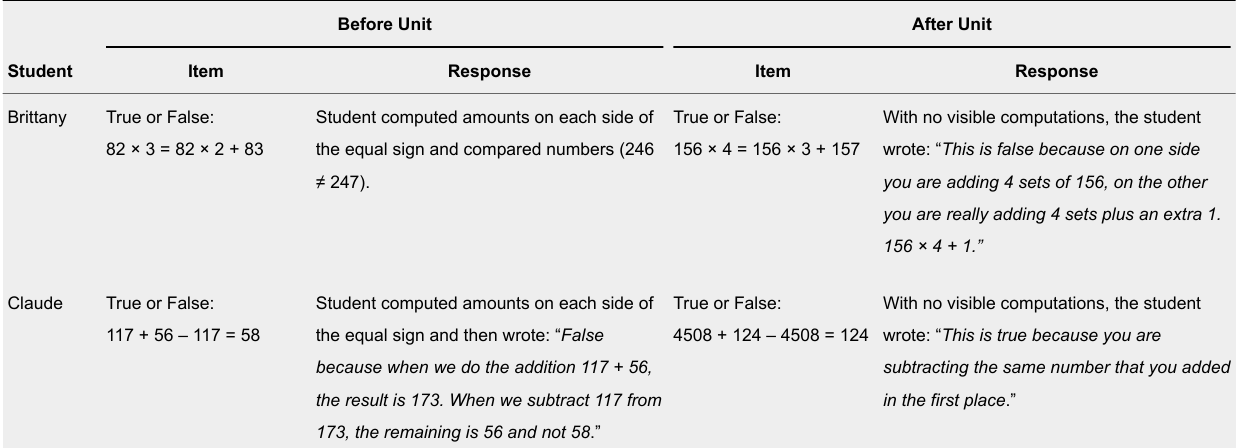
Illustrative Examples of Responses on Selected Items From the RTT Before and After the Mental Computation Unit Before